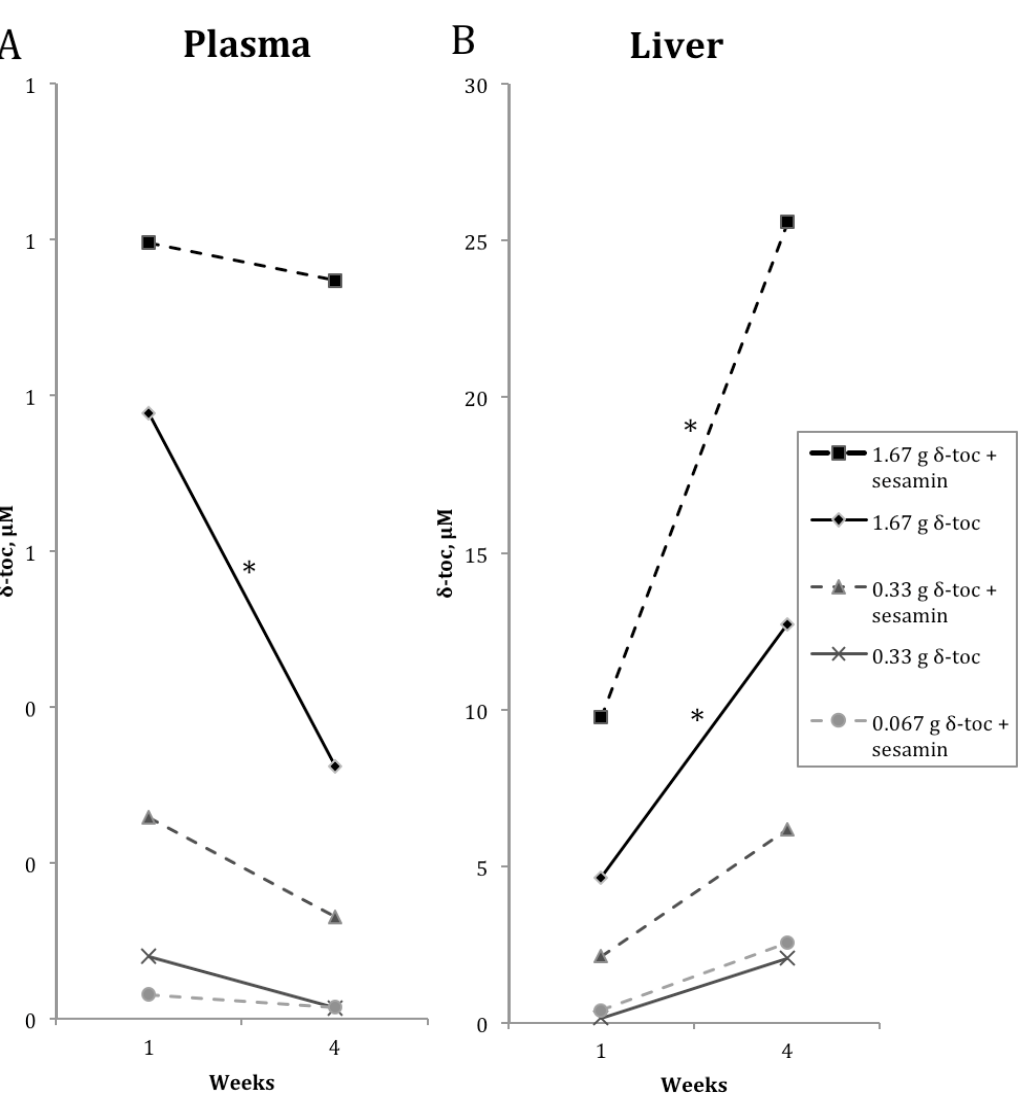
Figure 3. Comparison of mean δ -toc concentrations between the 1- and 4-week supplemental dietary δ -toc groups. ( A ) Plasma δ -toc levels decreased between 1 and 4 weeks when supplemental δ -toc at 1.67 g δ -toc/kg diet was given alone, but the co-supplementation of sesamin with δ -toc prevented this decrease. ( B ) Liver δ -toc levels increased between 1 and 4 weeks when supplemental δ -toc at 1.67 g δ -toc/kg diet was given alone, and co-supplementation of sesamin with δ -toc achieved higher δ -toc levels. No differences were seen at any of the 0.067 g or 0.33 g δ -toc dosages when comparing the 1-week and 4-week groups. * Statistically significant difference between mean δ -toc concentrations at 1 and 4 weeks by ANOVA followed by Tukey-Kramer multiple comparisons test, p <